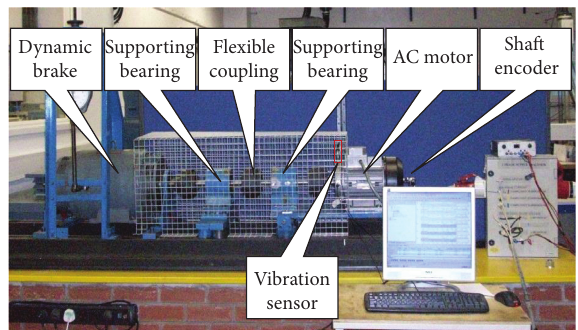
Figure 9: Rolling element bearing test platform.